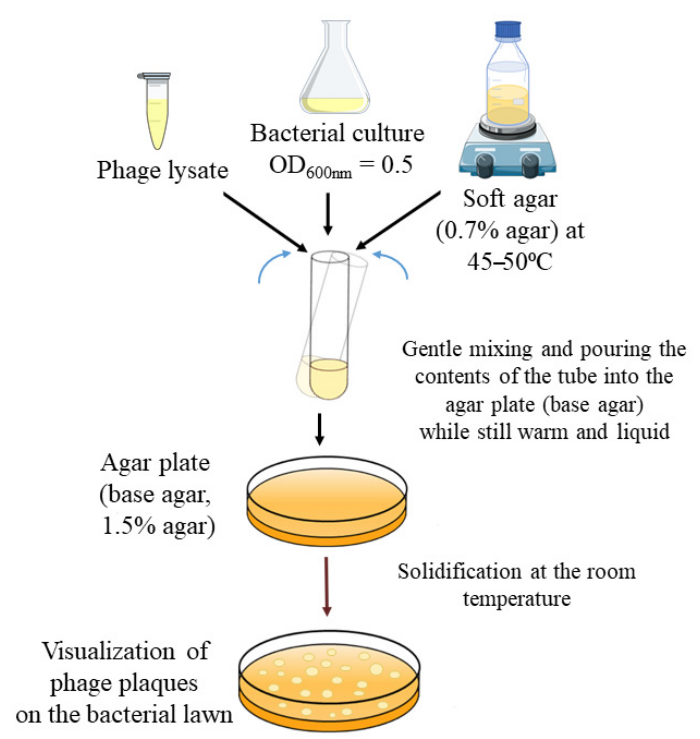
Figure 4. Standard double-layer agar (DLA) method visualization (prepared based on the method- ology described by Kropinski et al. [24]).